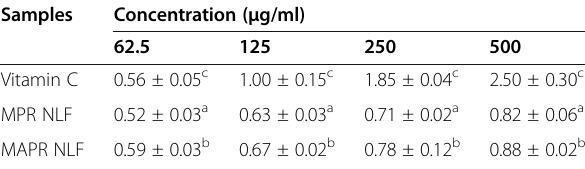
Table 2 Ferric reducing antioxidant power (FRAP) of methanol and methanol/acetone phenolic-rich extracts of NLF Samples